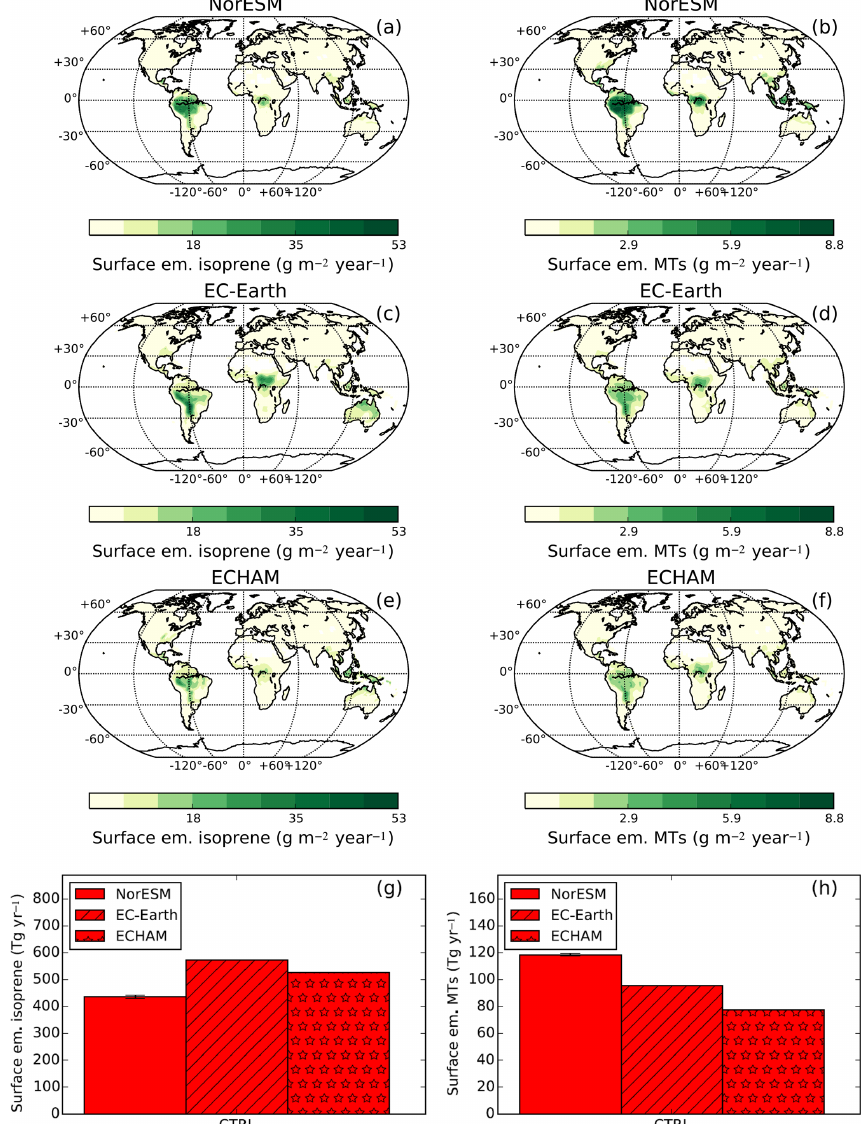
Figure 1. Maps of annually averaged surface emissions of isoprene (a, c, e) and monoterpenes (MTs) (b, d, f) for NorESM, EC-Earth and ECHAM. ECHAM and EC-Earth use prescribed emissions and there are therefore no error bars presented for these models. Also shown are the global yearly surface emissions of isoprene (g) and MTs (h) . The error bars denote the standard error of mean of the yearly